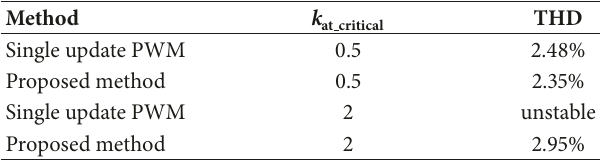
Table 3: The steady state simulation results of grid